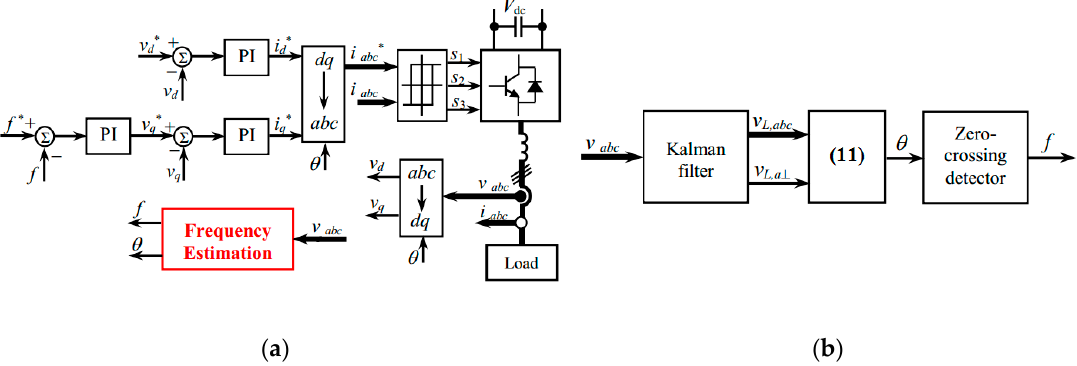
Figure 4. Load side control and estimation: ( a ) Control scheme; ( b ) frequency estimation.